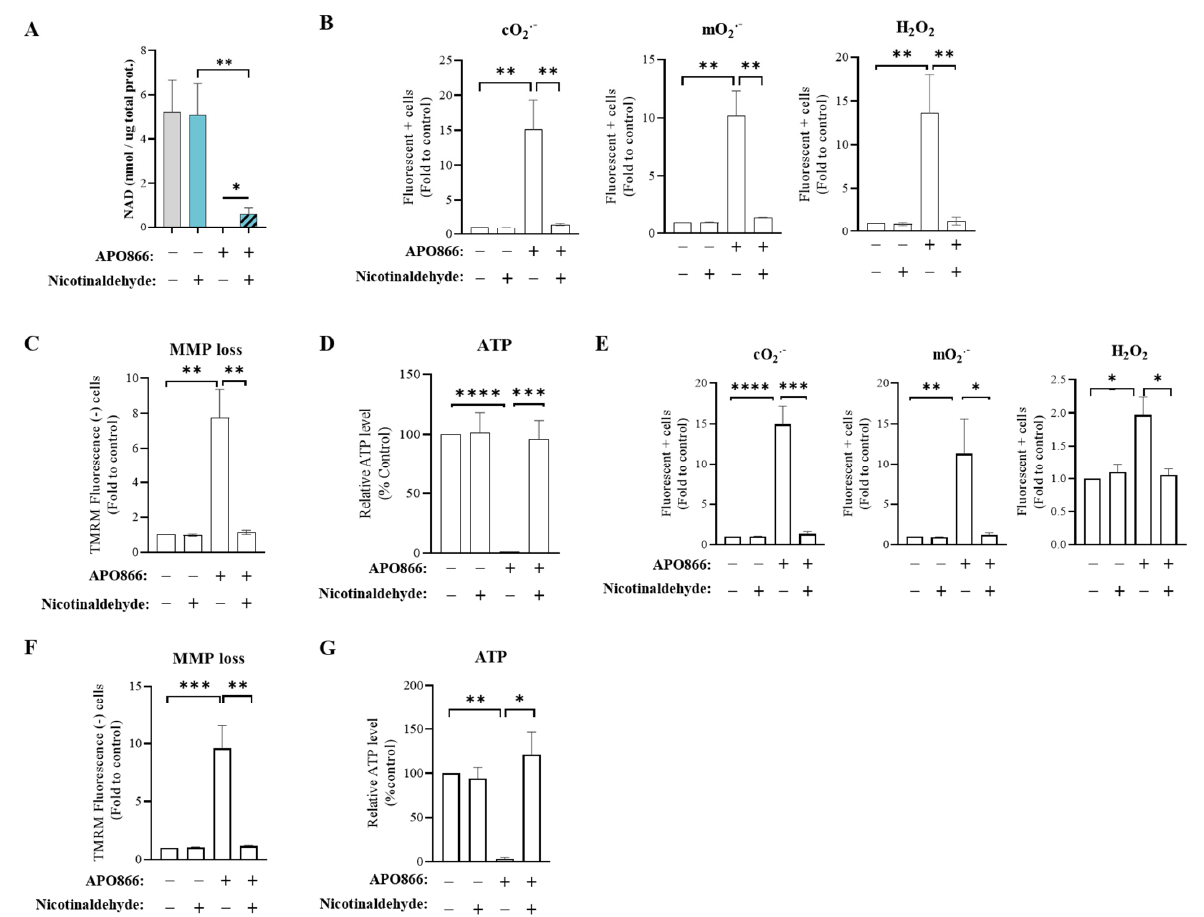
Figure 2. Nicotinaldehyde supplementation counteracts NAD depletion and abrogates cytotoxic events induced by APO866. Jurkat and ML2 cells were treated without or with 10 nM of APO866 in absence or presence of 10 µ M of nicotinaldehyde supplementation for 96 h to assess various cytotoxic signatures of APO866. ( A ) Intracellular total NAD (NAD + and NADH) measured by biochemical assay and normalized to protein concentration, in Jurkat cells at 96 h of treatment. ( B ) Intracellular ROS (cytosolic and mitochondrial superoxide O 2 − and cellular hydrogen peroxide H 2 O 2 ) levels measured with specific probes (DHE, mitosox and H2DCFDA, respectively) by flow cytometry in Jurkat cells. ( C ) Mitochondrial membrane potential (MMP) determined with TMRM staining, using flow cytometry in Jurkat cells ( D ) ATP concentration measured by luminescence assay, relative to the concentration in untreated cells. ( E ) ROS, ( F ) MMP and ( G ) ATP concentration in ML2 cells. Data are mean ± SD, n ≥ 3. * P < 0.05, ** P < 0.01, *** P < 0.001, **** P < 0.0001.